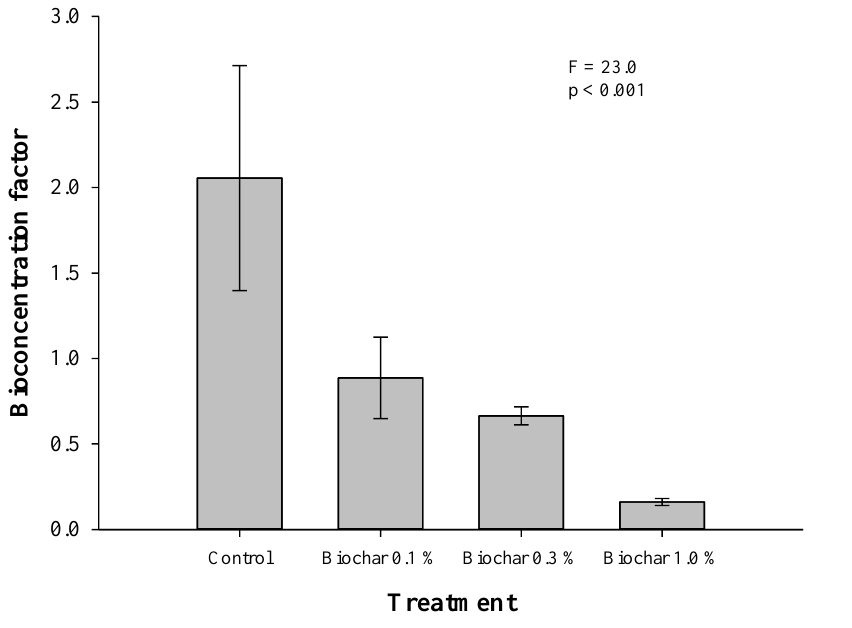
Figure 7. Endosulfan concentration of two-year-old ginseng under different biochar treatments.